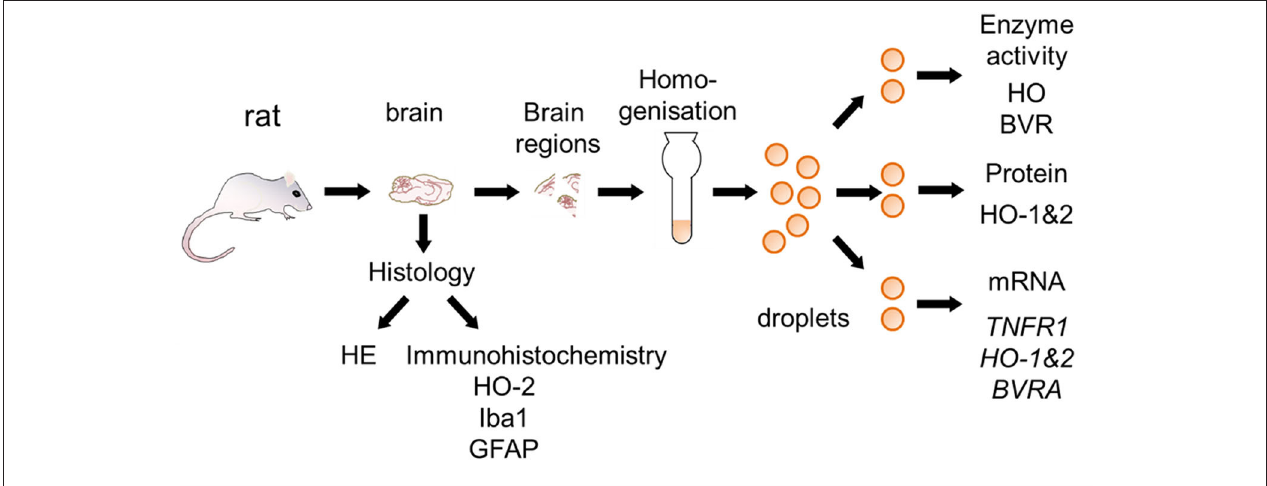
FIGURE 2 | Schematic overview for the preparation of brain sections used for the different analysis. Brain samples were taken from rats surviving 2 weeks following CA and processed as described in the Materials and Methods section. Half of the brain was fixed and used for histological examination [hematoxylin and eosin staining (HE), immunohistochemistry for heme oxygenase (HO)-2, ionized calcium-binding adapter molecule 1 (Iba-1), and glial fibrillary acidic protein (GFAP)]. Different regions were cut from the other half and immediately snap-frozen. In order to prevent biases frozen tissue pieces were homogenized and distributed into droplets prior to analysis of activity of HO and BVR, protein expression of HO-1 and HO-2, and gene expression [ Tumor necrosis factor receptor 1 (TNFR1), HO-1, HO-2, and biliverdin reductase A (BVRA)]. Analyses were performed in accordance to the procedures described in Materials and Methods section.